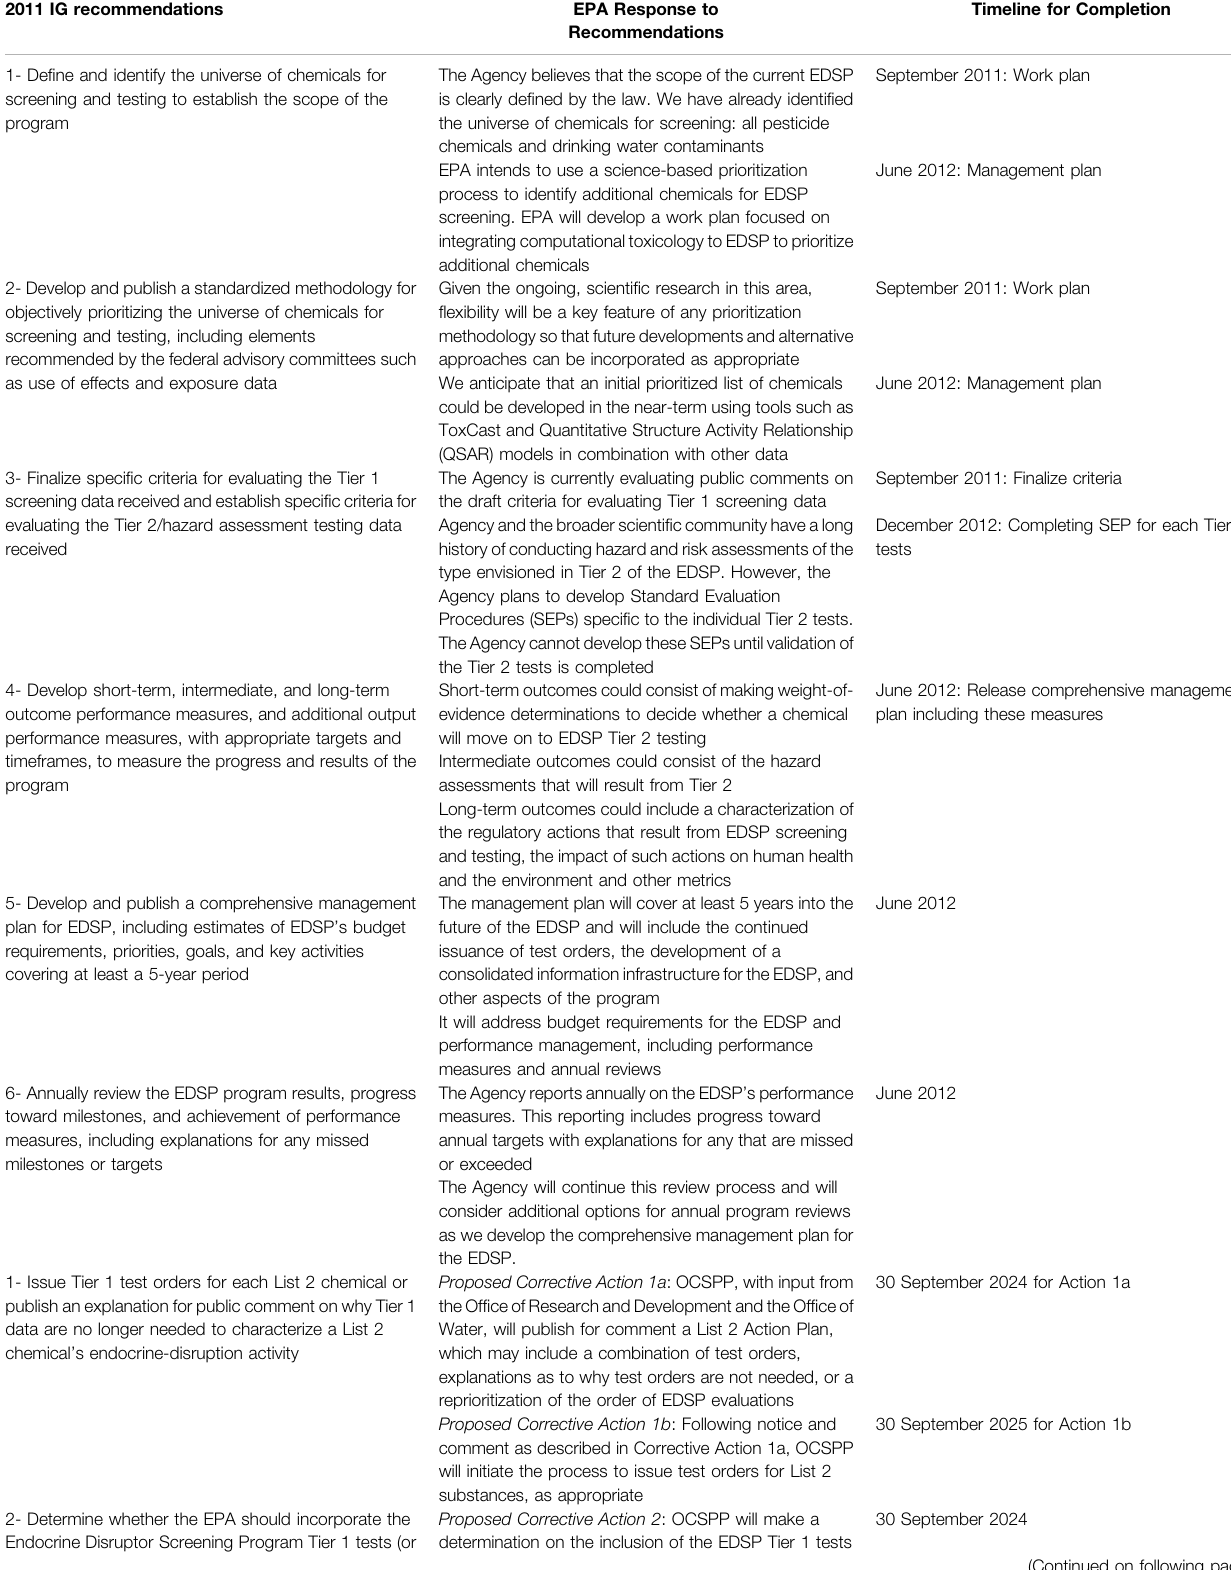
TABLE 1 | Synthesis of the EPA ’ s Inspector General 2011 and 2021 recommendations to improve the implementation of